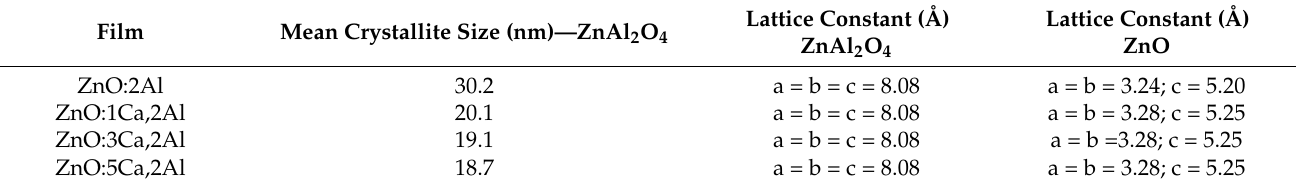
Table 1. Mean crystallite size (nm)—ZnAl 2 O 4 , the lattice constant (Å)—ZnAl 2 O 4 and the lattice constant (Å) ZnO.